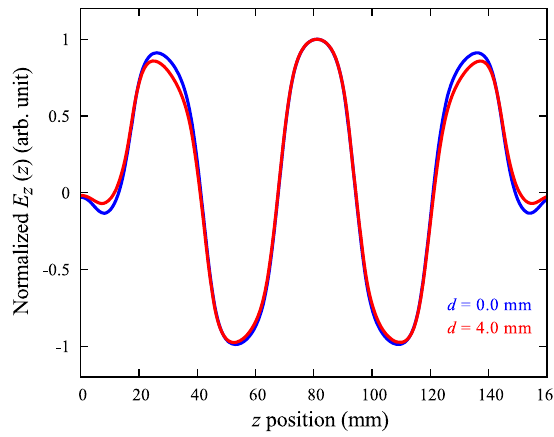
FIG. 2. Conceptual illustrations of the end cell containing a frequency tuning structure. The inner and outer radii of the concentric circular groove are set to r 1 and a 1 , respectively. The groove depth of it is defined in d .